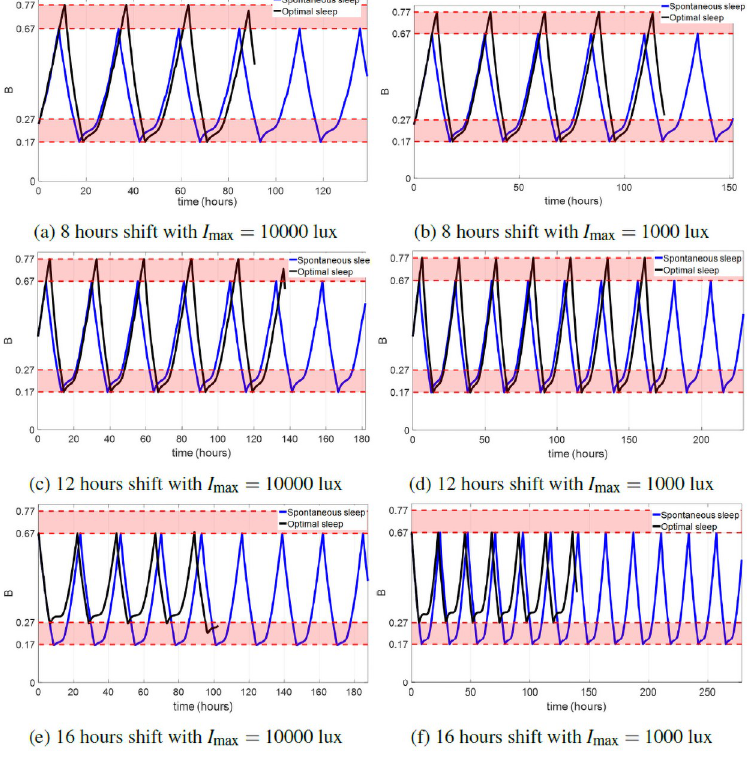
Fig 5. Sleepiness comparison of the minimum-time entrainment with spontaneous sleep (blue curves) and with optimal (controllable) sleep (black curves). In this figure, we only plot the sleepiness value during the entrainment process (i.e., before reaching the terminal condition in Eq (14)). The black curves terminate earlier than the blue curves, emphasizing that the entrainment times with optimal sleep are shorter than those with spontaneous sleep.